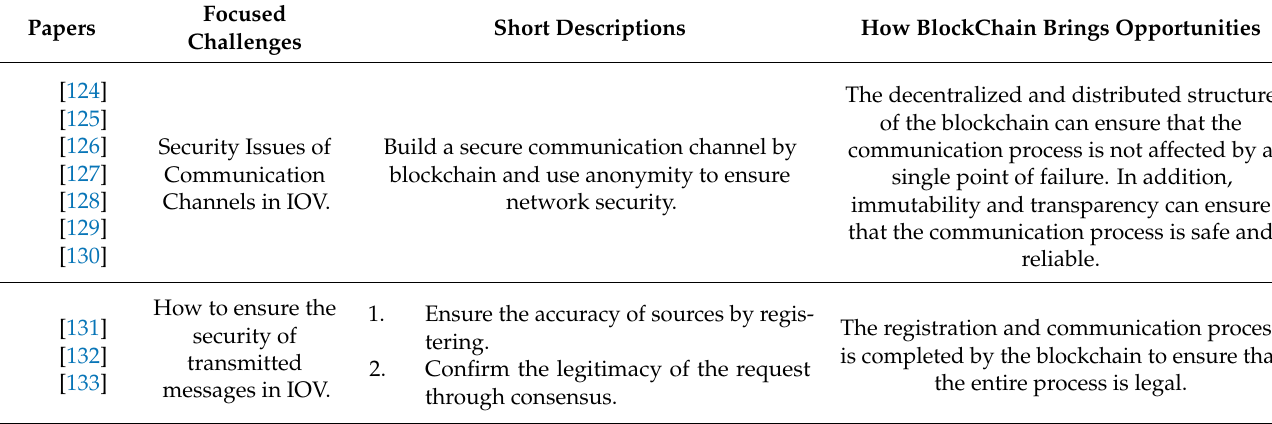
Table 6. communication Security Related